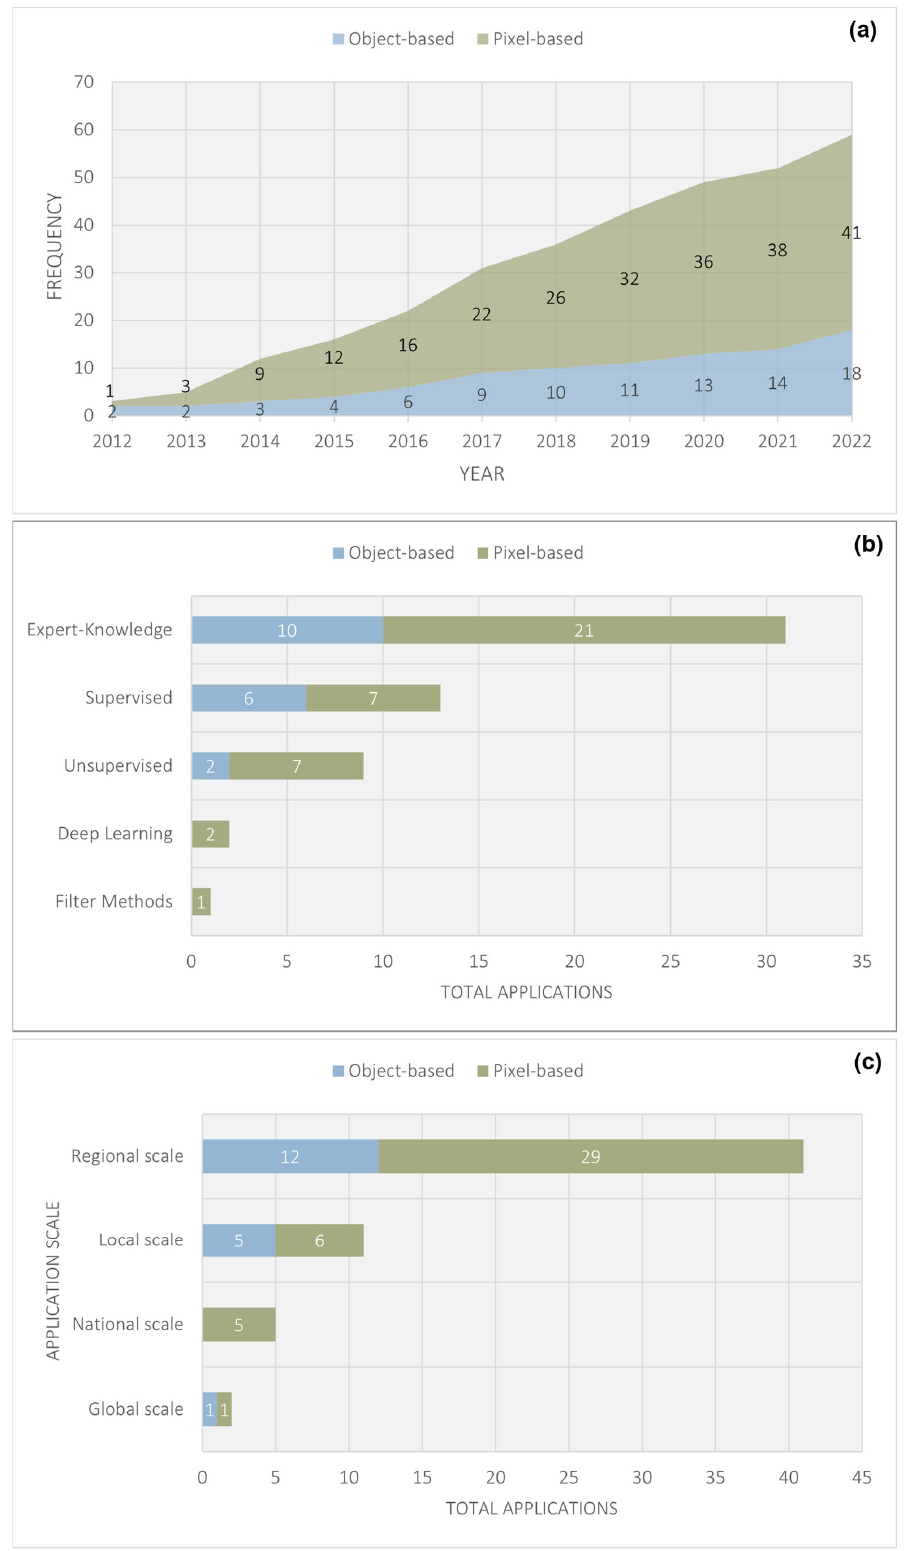
Figure 7. Analysis unit cumulative trends (a); analysis unit versus methods (b); analysis unit and scales of application (c).